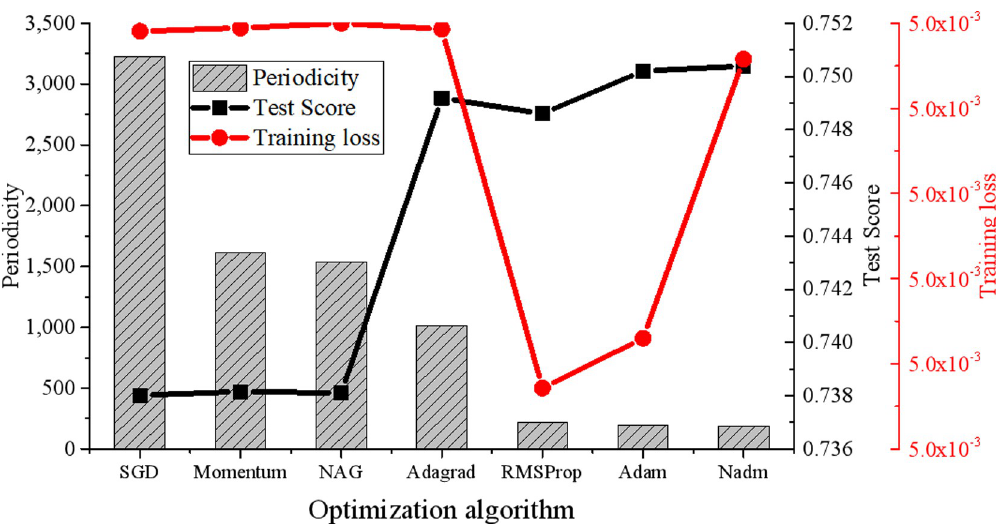
Fig 6. Comparison of training results of different optimization methods.